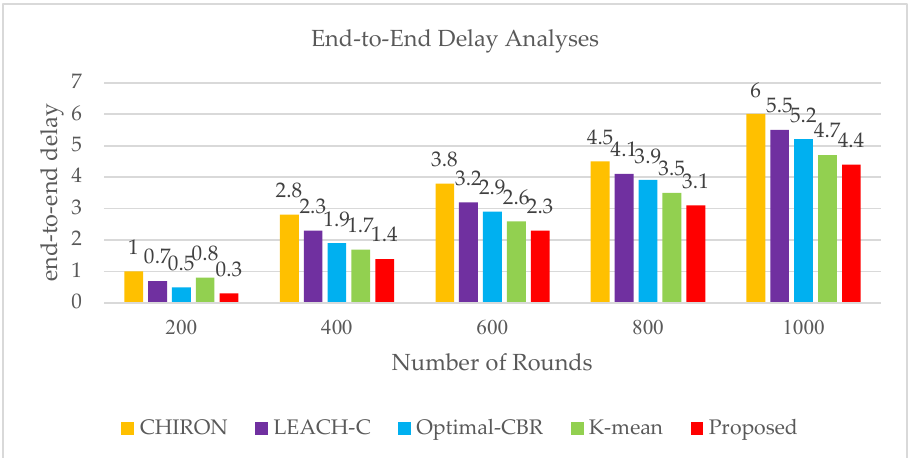
Figure 4. Comparison end-to-end delay analyses.